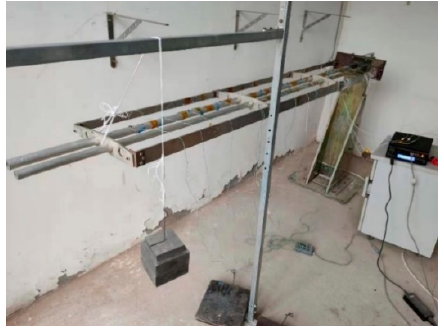
Figure 7. Model loading. Table 3. Loading weight in different working conditions.